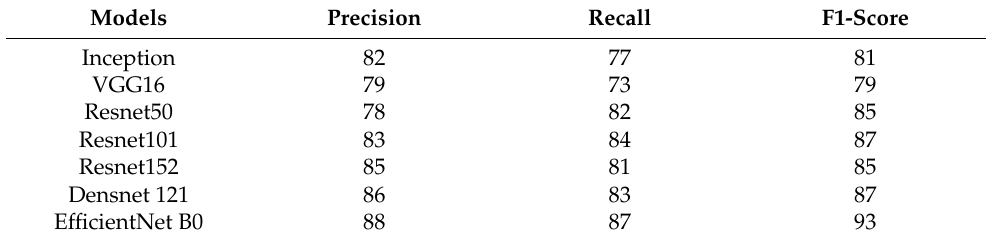
Table 6. Comparison analysis of the proposed model under Precision, Recall, and F1-score. Models Table 7. Comparison analysis of the proposed model under IoU, mAP, and CT. Table 7. Comparison analysis of the proposed model under IoU, mAP, and CT. Models